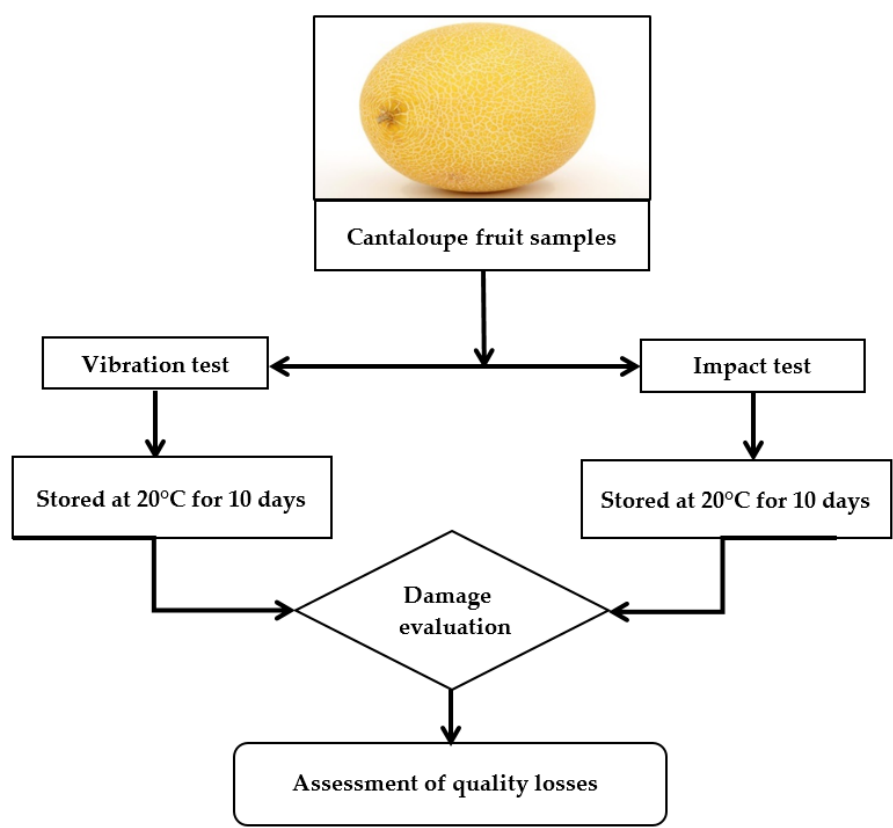
Figure 1. Flowchart describing the experimental setup (impact and vibration tests) on cantaloupe fruit.